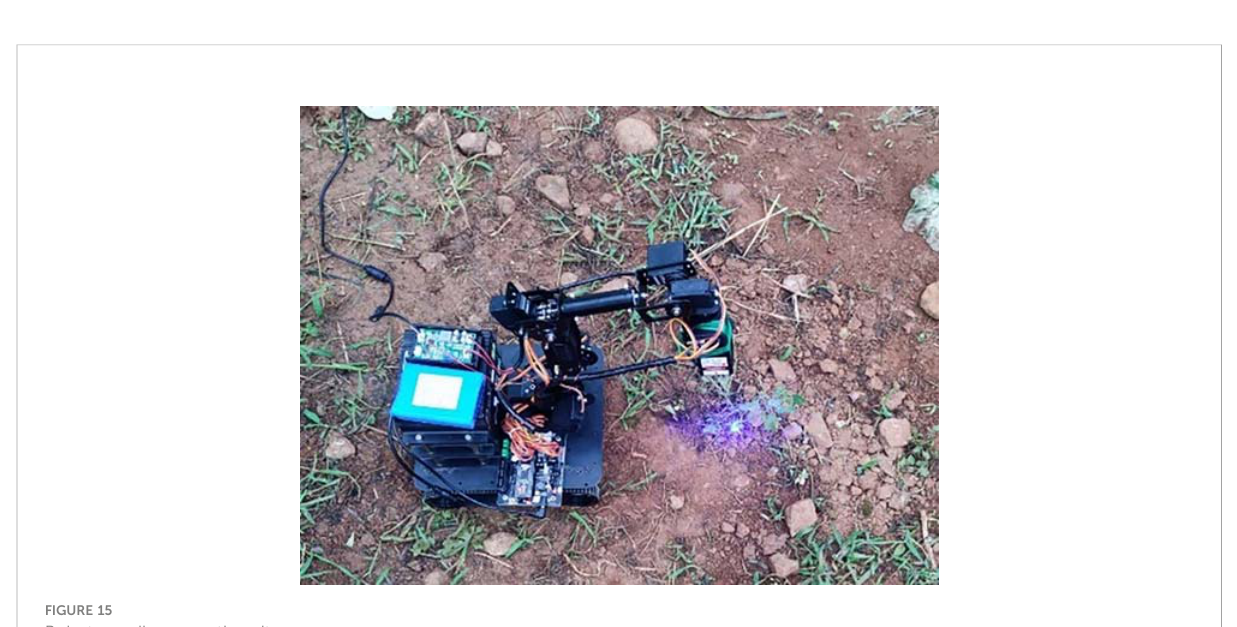
FIGURE 15 Robot weeding operation site.